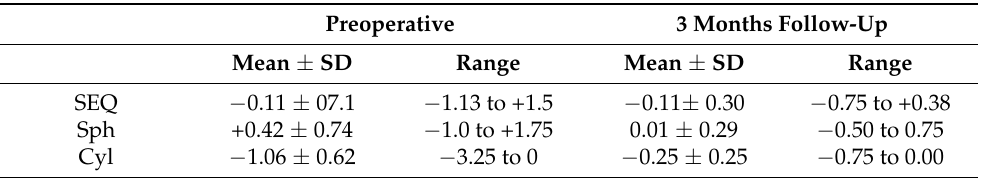
Table 1. The preoperative spherical equivalent (SEQ) with standard deviation (SD), sphere (sph), and cylinder (Cyl) compared with the results after 3 months